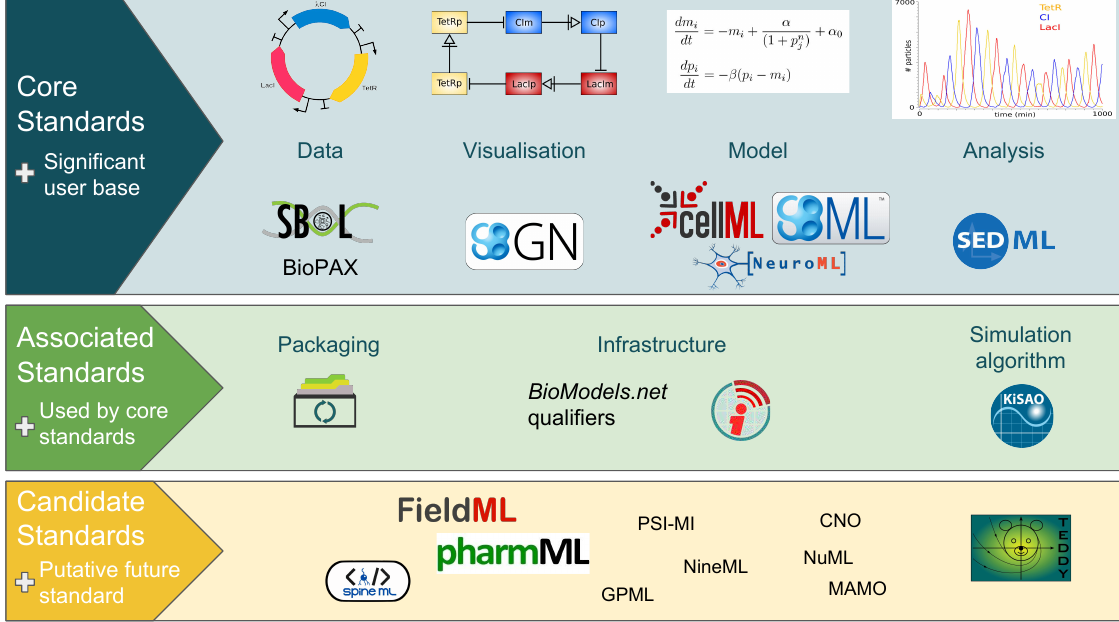
algorithmInfrastructurePackaging